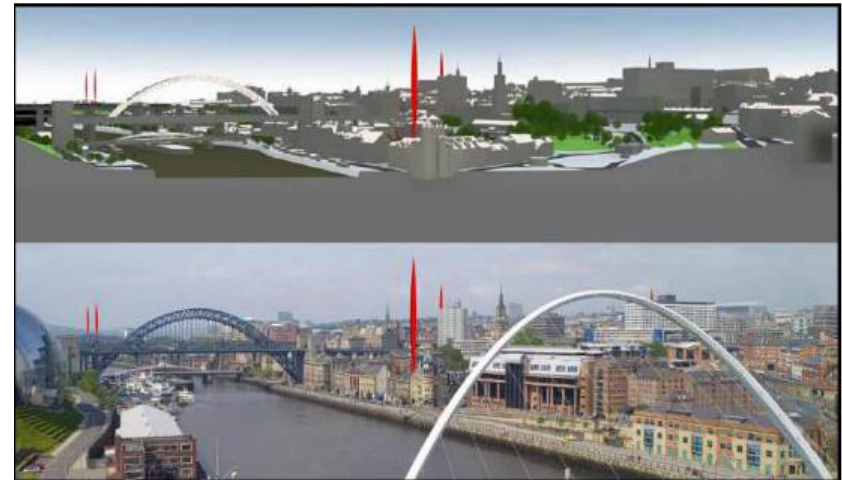
Figure 5. Verification of accuracy of Virtual Newcastle Gateshead. Source: Horne,